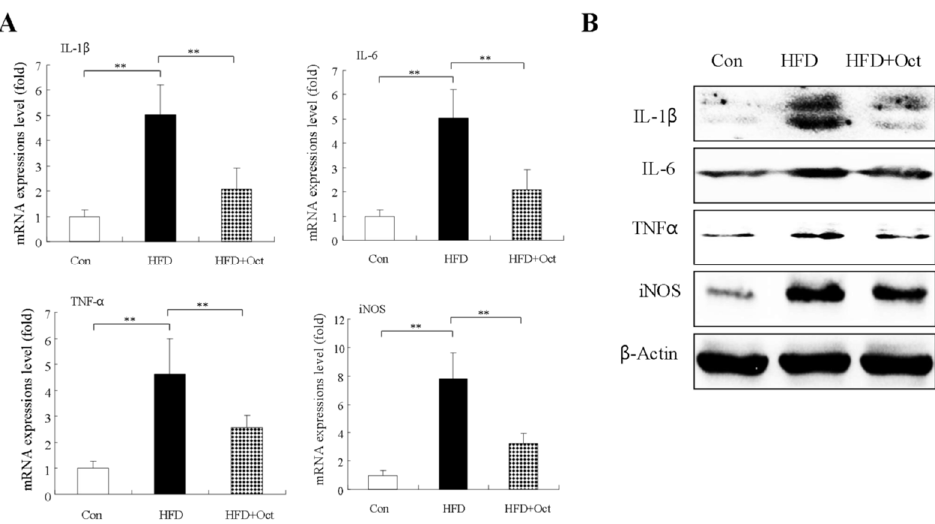
Figure 11. Octacosanol inhibits expression levels of inflammatory factors in the liver tissues of HFD mice. ( A ) Expression levels of cytokines, including IL-6, TNF- α , and iNOS, were examined by the RT-qPCR analysis (three independent experiments). ( B ) WB analyses of the relative expression of IL-6, TNF- α , and iNOS (three independent experiments). Oct, octacosanol; HFD, high-fat diet; **: p < 0.01. Octacosanol inhibits expression levels of inflammatory factors in the liver tissues of HFD mice.